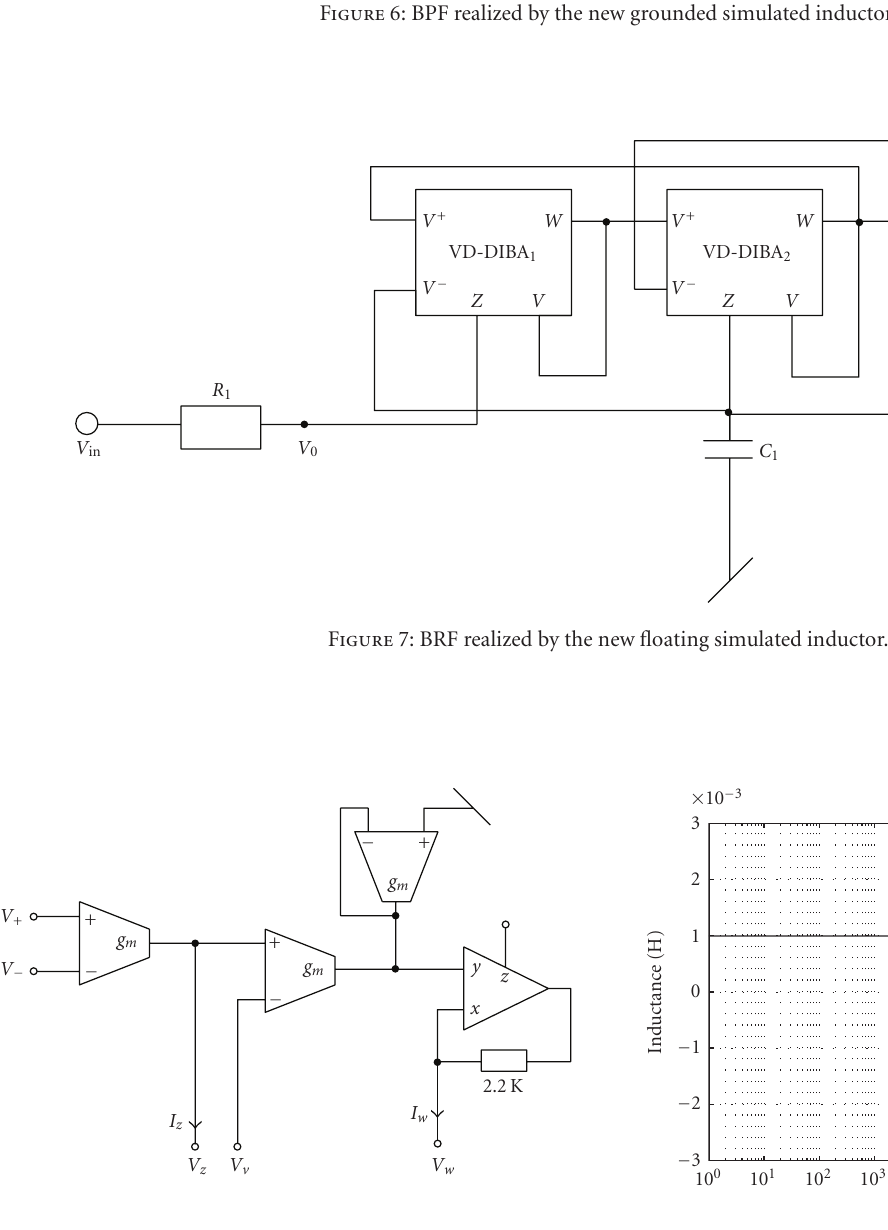
Figure 8: A possible implementation of VD-DIBA. Figure 9: Frequency response of simulated grounded